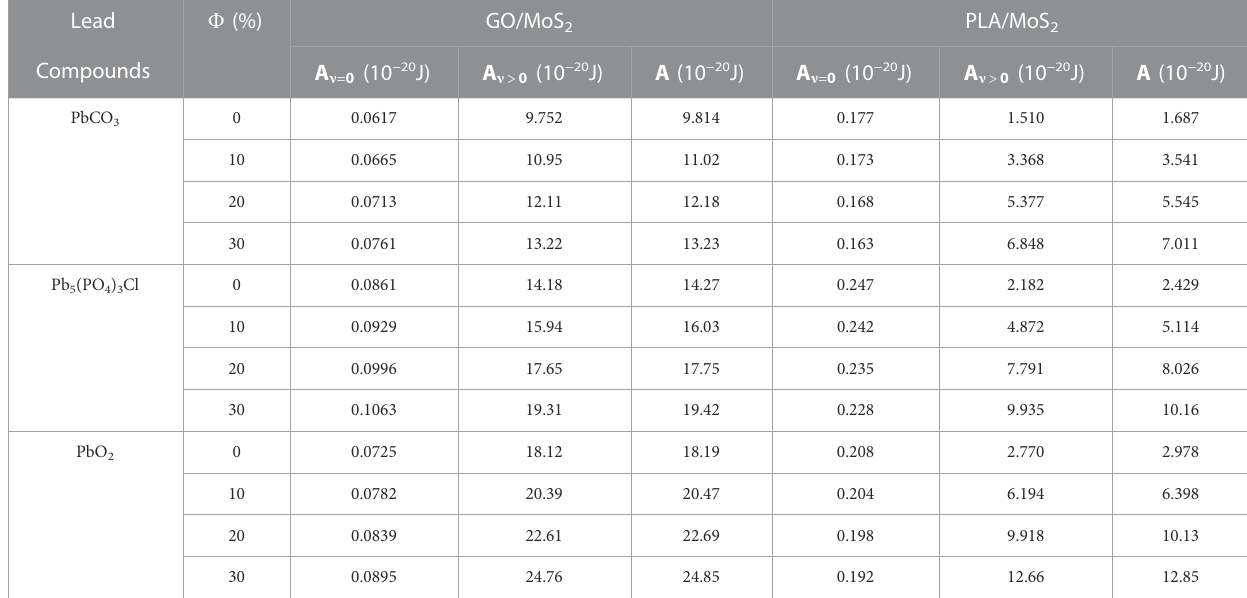
TABLE 4 Non-retarded Hamaker constants for the interactions between adsorbent nanocomposites (GO/MoS 2 and PLA/MoS 2 ) and the lead-insoluble adsorbates